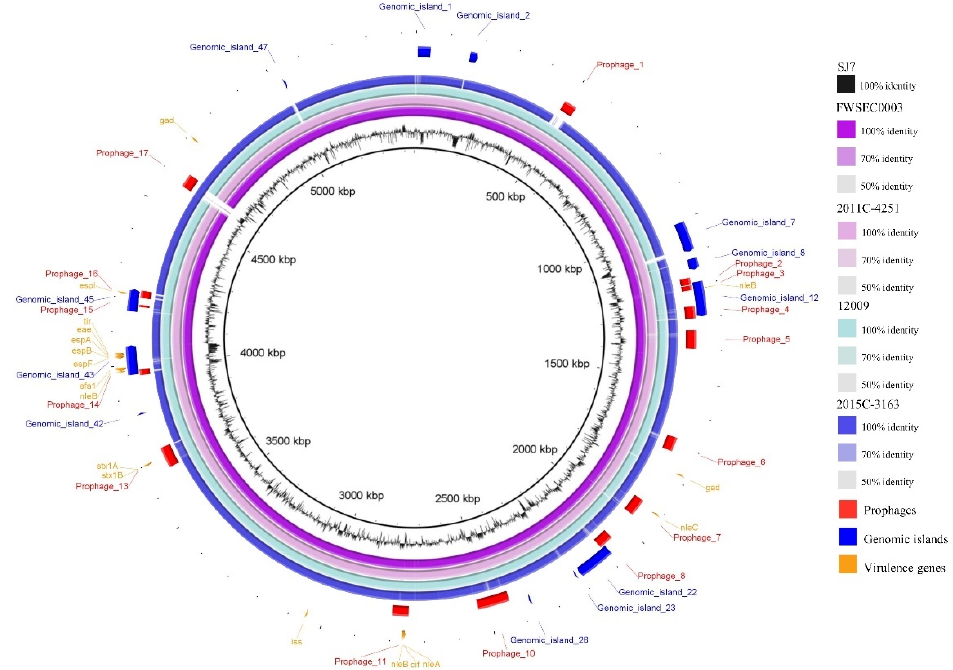
Figure 3. Comparative analysis of the complete chromosome of the STEC O45:H2 strain SJ7 with two STEC O45:H2 and two STEC O103:H2 reference strains. The BLAST comparison of STEC chromosomes and the chromosome of E. coli O45:H2 strain SJ7 was generated using the BLAST Ring Image Generator (BRIG) with a minimum nucleotide sequence identity of 50%. The bacterial chromosomes from inside out represent E. coli O45:H2 SJ7 (black), E. coli O45:H2 FWEC0003 (dark purple), E. coli O45:H2 2011C-4251 (light purple), E. coli O103:H2 12009 (light blue), and E. coli O103:H2 2015C-3163 (dark blue). Color codes for di ff erent degrees of nucleotide sequence homologies based on comparison to SJ7 are listed. The prophages ( red ), genomic islands ( navy ), and virulence genes ( yellow ) annotated in the SJ7 chromosome are present at the outermost three rings.